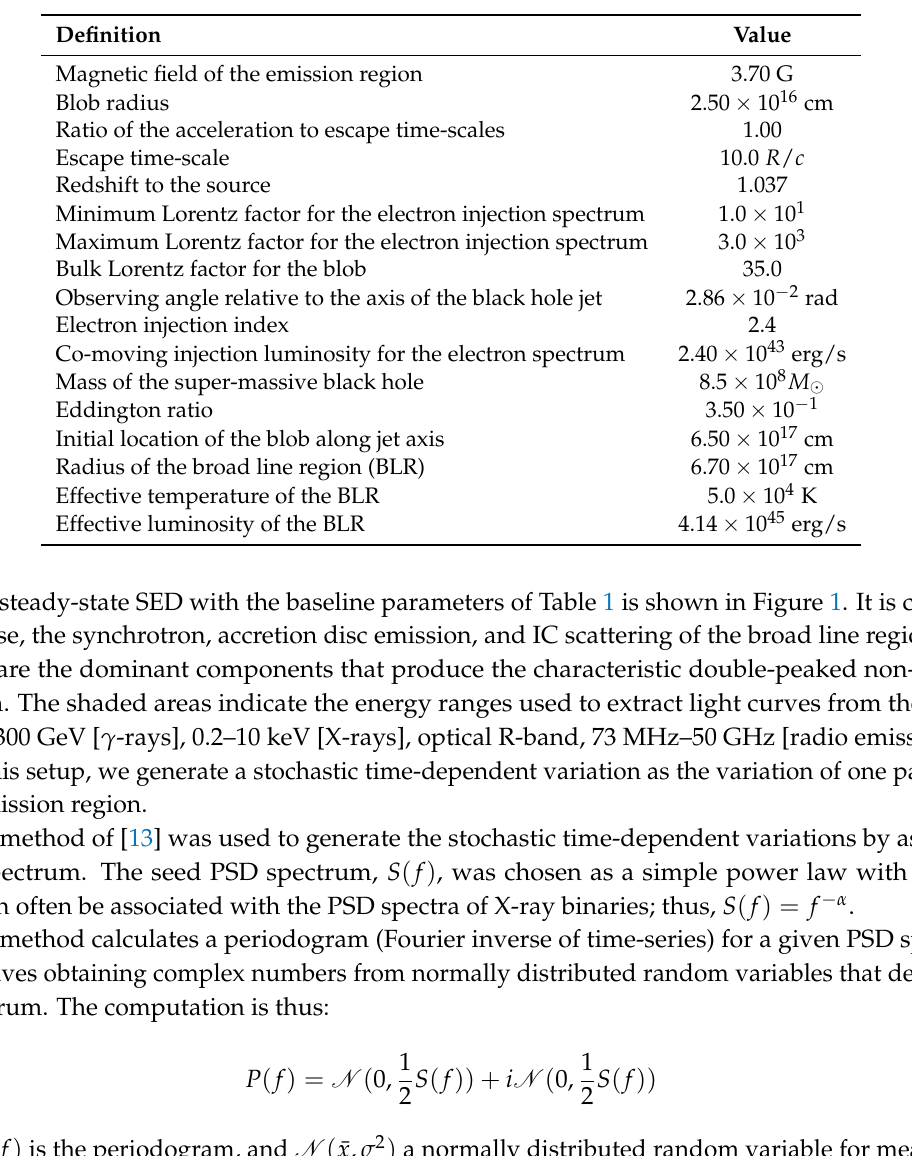
Table 1. Baseline model parameters used in the leptonic code, similar to that of